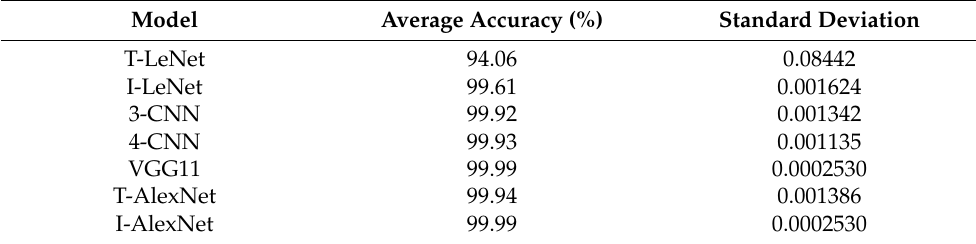
Table 3. Average classification accuracy of different CNN